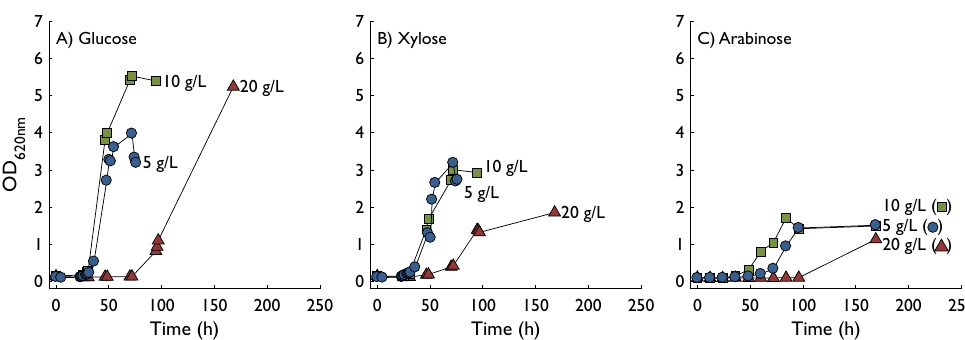
Figure 2. Optical density (620 nm) of cultures of C. crescentus in defined M2 medium supplemented with glucose ( A ), xylose ( B ) or arabinose ( C ) as substrate. Growth was monitored in three levels of substrate, 5 g L − 1 (circles), 10 g L − 1 (squares) or 20 g L − 1 (triangles). Data shown in this figure represents experiments performed in biological duplicates.